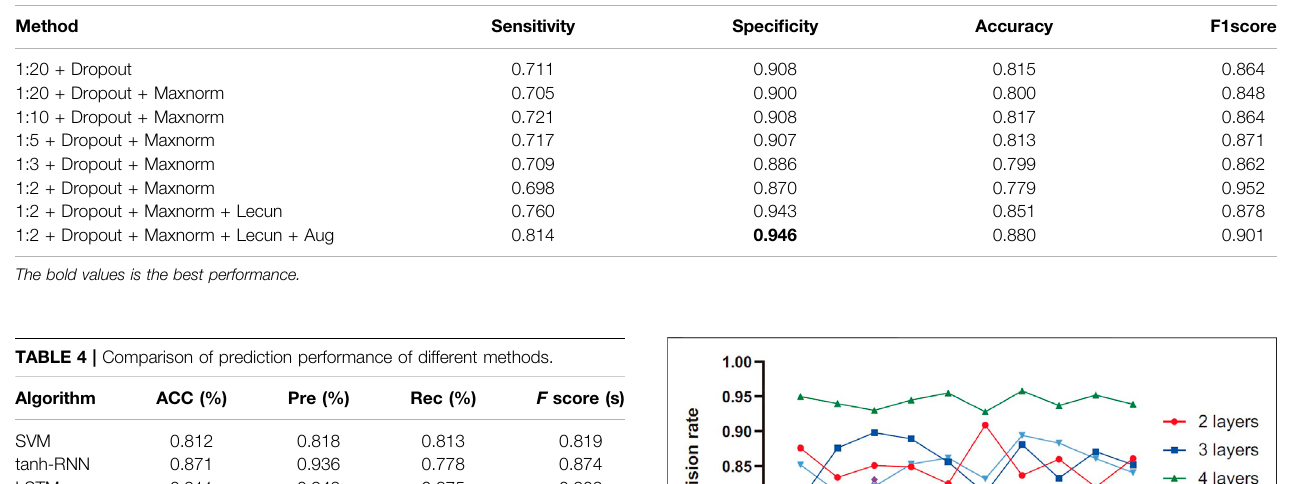
TABLE 3 | The classi fi cation results and network parameters on cooperative hospital test set.